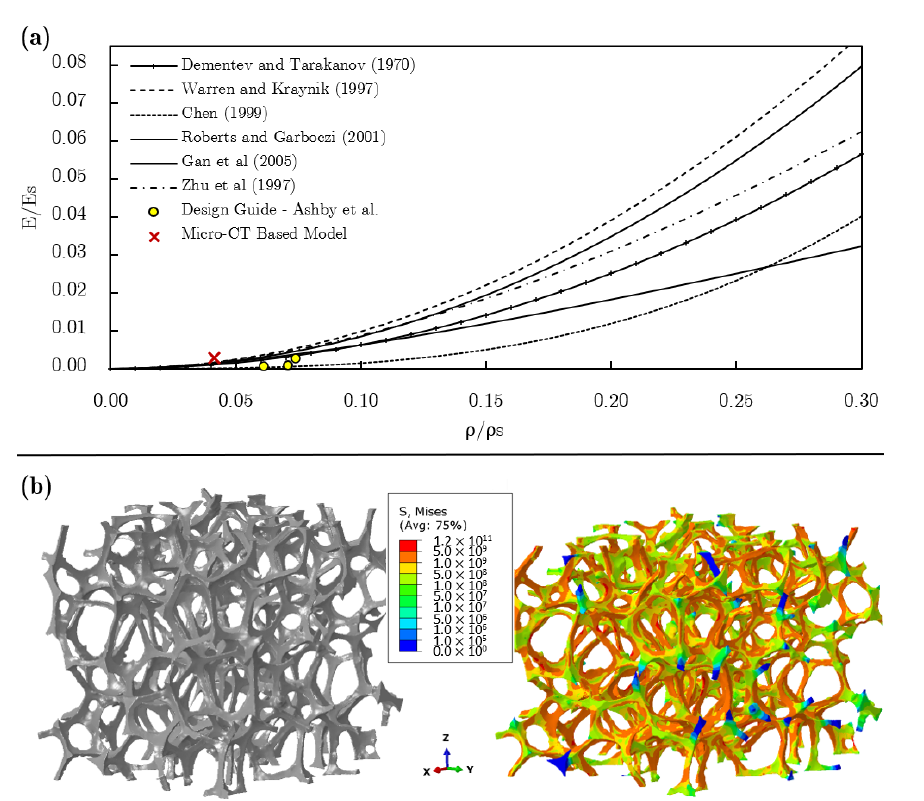
Figure 15. ( a ) Relative Young’s modulus of the cubic open-cell foam specimen (Procedure 1, i.e., plain simplification), models and experimental results and ( b ) stress distribution (equivalent von Mises) for the cubic open-cell foam for a compression